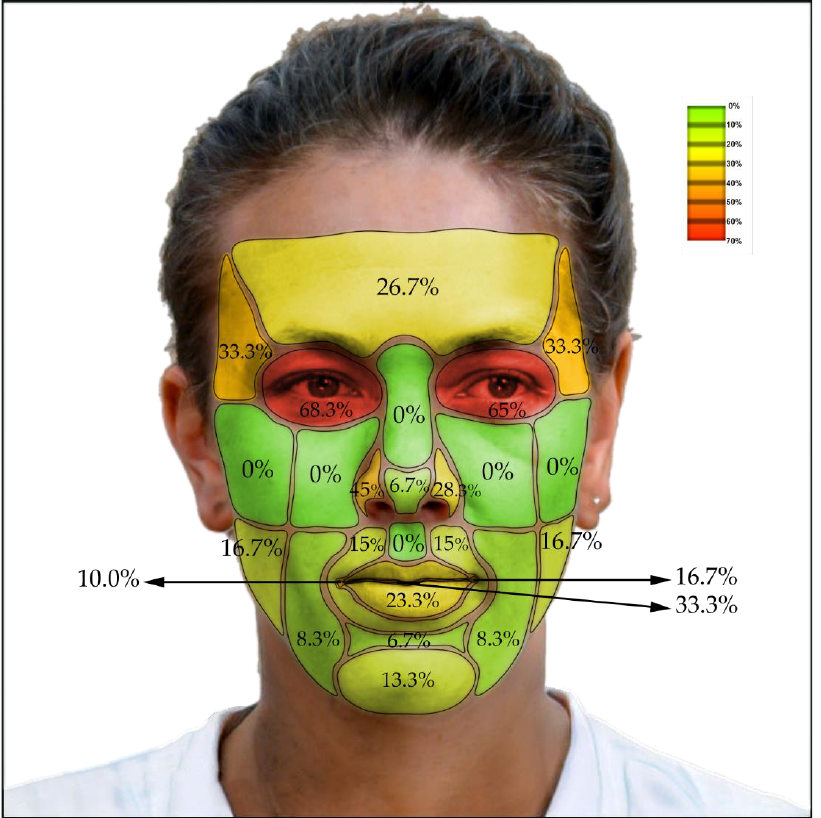
Figure 5. The percentage of deviation in TrueDepth (Bellus3D Dental Pro) scans from CBCT scans — all results together.